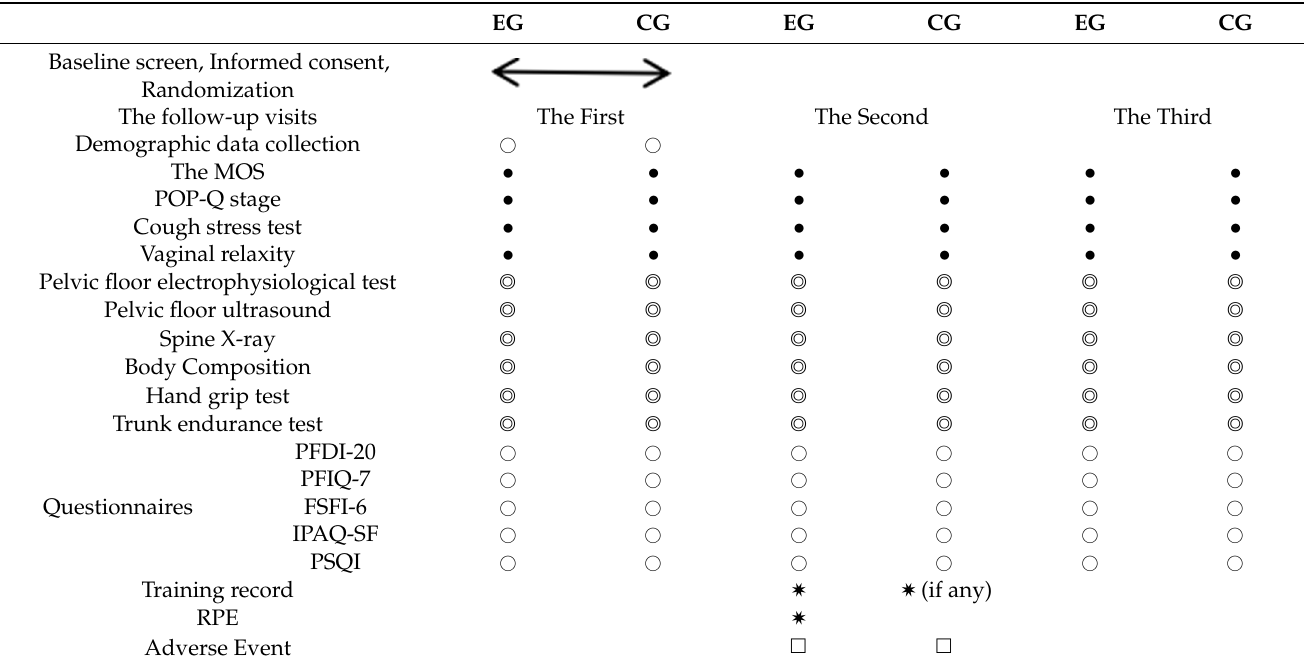
Table 2. Data collection and follow-up instruments.